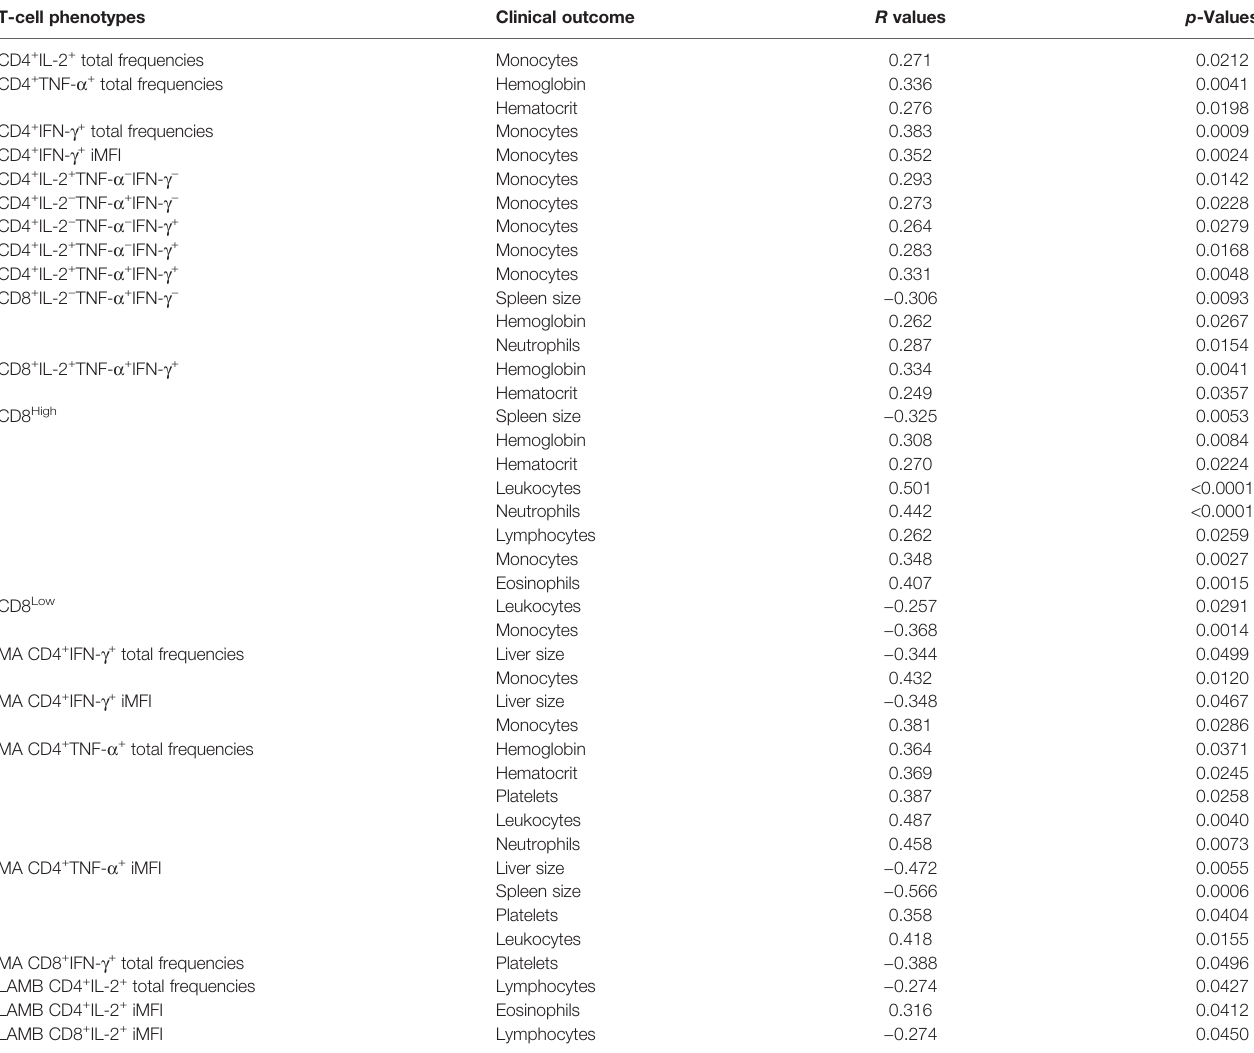
TABLE 2 | Correlation between clinical outcomes and CD4 + and CD8 + T-cell phenotypes. T-cell